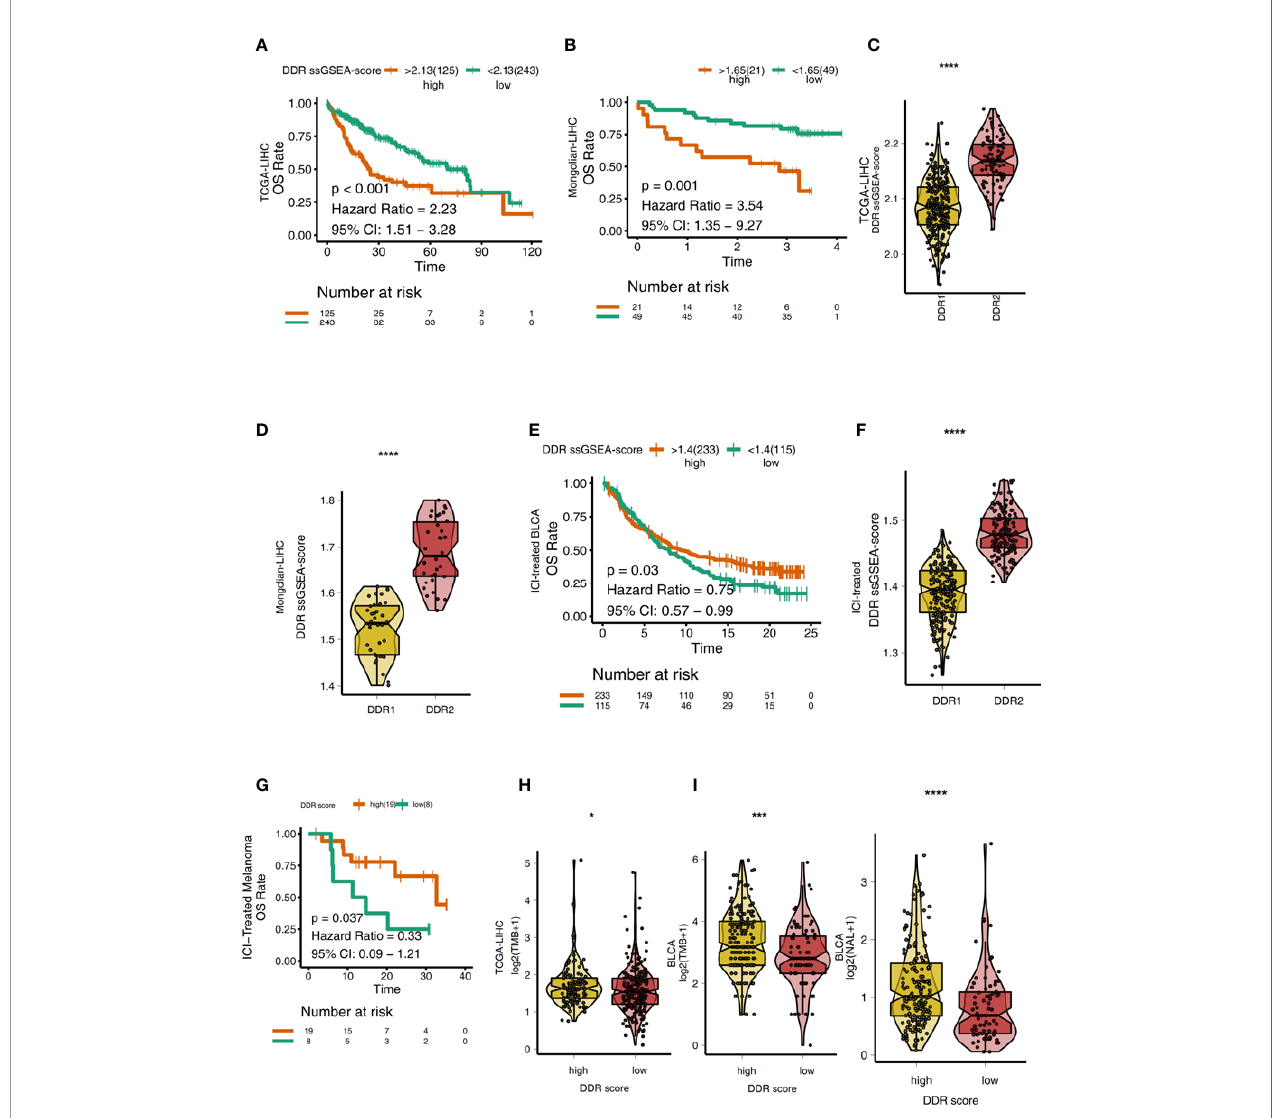
FIGURE 5 | (A) Overall survival for subjects grouped according to DDR score subtype (high DDR score and low DDR score) in the TCGA-LIHC cohort. (B) Overall survival for subjects grouped according to DDR score subtype (high DDR score and low DDR score) in the Mongolian-LIHC cohort. (C) Comparison of the DDR scores between two molecular subclasses (DDR1 and DDR2) in the TCGA-LIHC cohort. (D) Comparison of the DDR scores between two molecular subclasses (DDR1 and DDR2) in the Mongolian-LIHC cohort. (E) Overall survival for subjects grouped according to DDR score subtype (high DDR score and low DDR score) in the ICI-treated BLCA cohort. (F) Comparison of the DDR scores between two molecular subclasses (DDR1 and DDR2) in the ICI-treated BLCA cohort. (G) Overall survival for subjects grouped according to DDR score subtype (high DDR score and low DDR score) in the ICI-treated melanoma cohort. (H) Comparison of TMB between two molecular subclasses (high DDR score and low DDR score) in the TCGA-LIHC cohort. (I) Comparison of TMB and NAL between two molecular subclasses (high DDR score and low DDR score) in the ICI-treated cohort. (*P < 0.05; ***P < 0.001; ****P < 0.0001; Mann-Whitney U